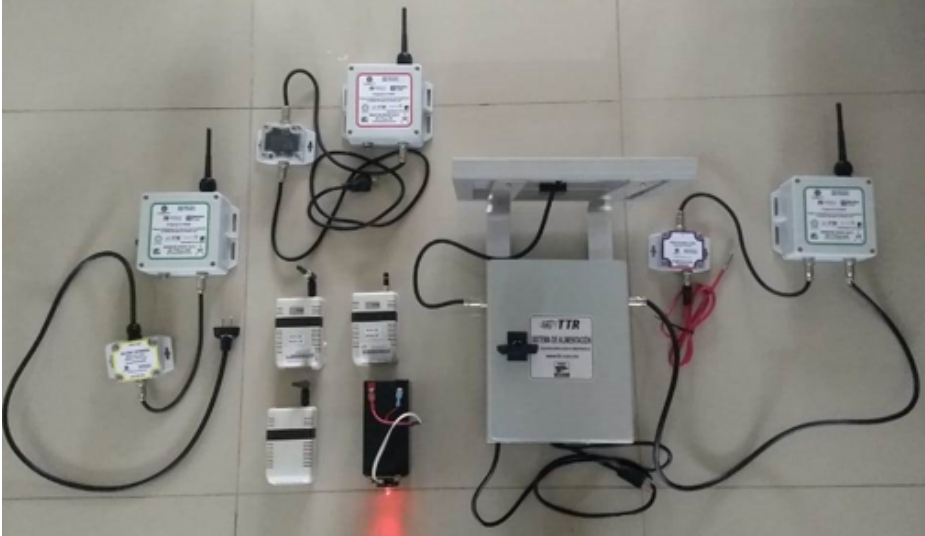
Figure 1. Wireless network with radiofrequency